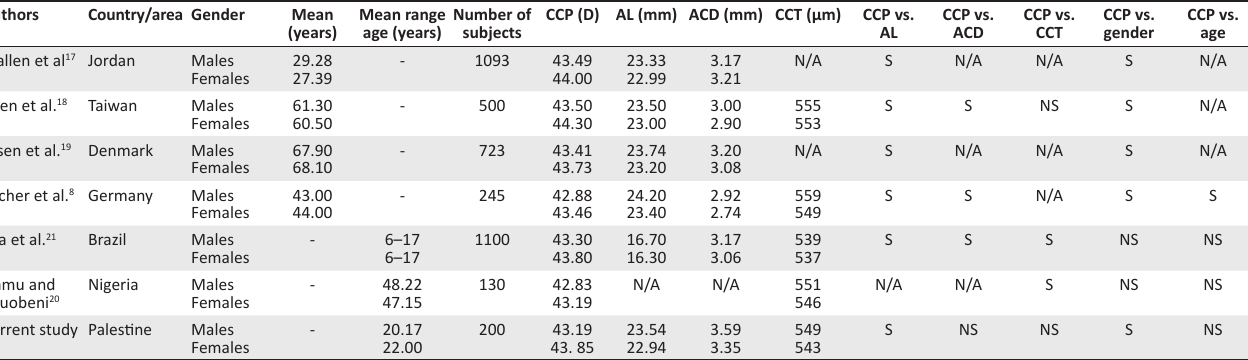
TABLE 5: Summary of reports presenting the correlation between central corneal power and a number of variables, which include axial length, anterior chamber depth, central corneal thickness, gender and age. Authors Country/area